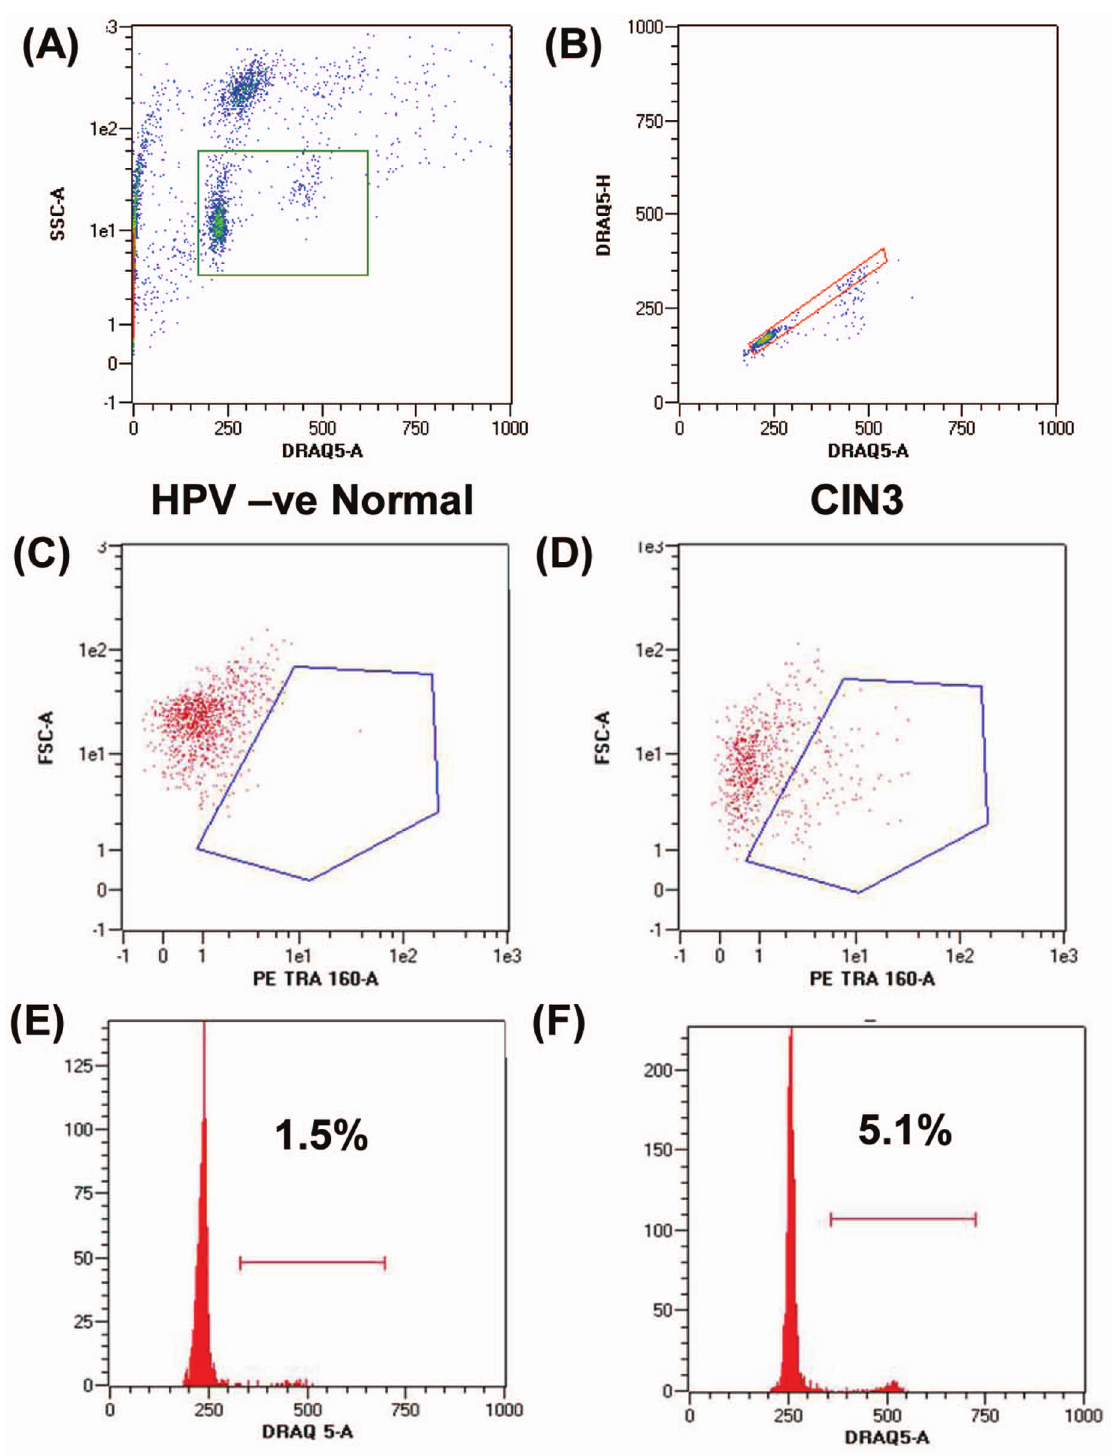
Fig. 1. Sample Flow Cytometry analysis showing gating strategy. Debris (no DNA stain) and cell clumps (high SSC) are excluded from the analysis (A). Doublets excluded by plotting DRAQ5 area versus height (B). (C) and (D), Cells in HPV-ve normal samples do not stain with anti-TRA-1-60 but strong staining is seen in some samples from women with CIN3 (gates set against individual sample isotype controls). (E) and (F), representative cell cycle